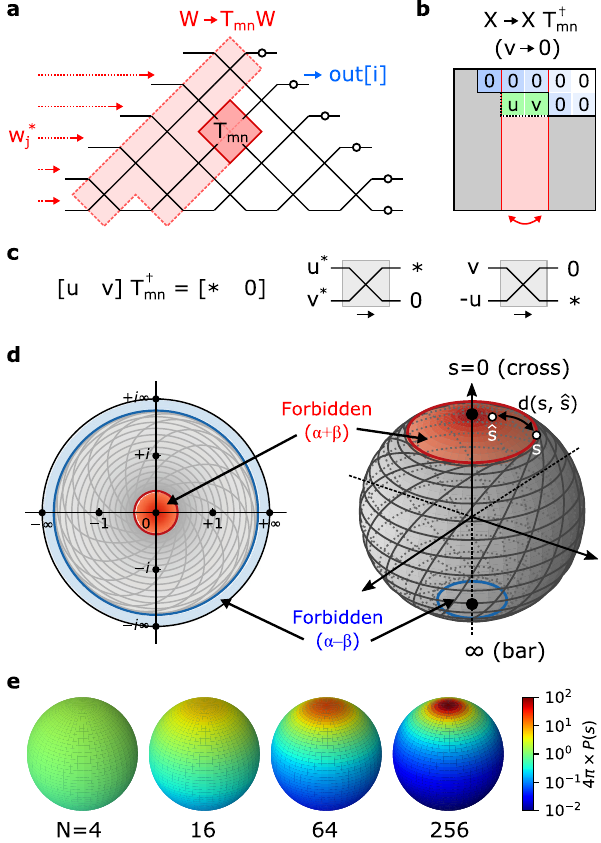
Fig. 2 | Nulling method of self-con fi guration. a Con fi guring MZI T mn updates matrix W . b Corresponding nulling update to X = UW † , which is c equivalent to zeroing an output of T mn given a fi xed input. d Allowed range of s = T 11 = T 12 2 C , showing the forbidden regions centered at s =0and s = ∞ thatarise from hardware imperfections ( α =0.23, β =0.07 chosen for illustrative purposes). Contours for ( θ , ϕ ) are plotted in the accessible region (gray). e Probability density P ( s ) plotted on the Riemann sphere for meshes of size N =4, 16, 64, and